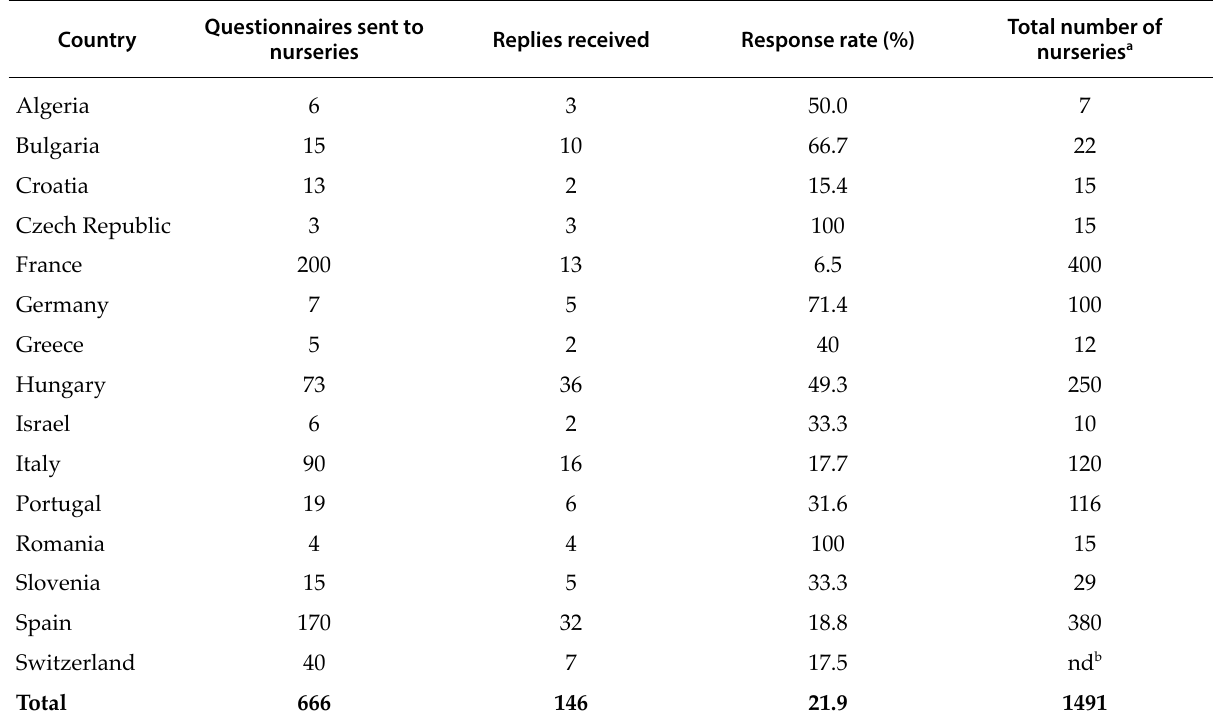
Table 1. Data of the European grapevine propagation nursery survey. Questionnaires sent to Country